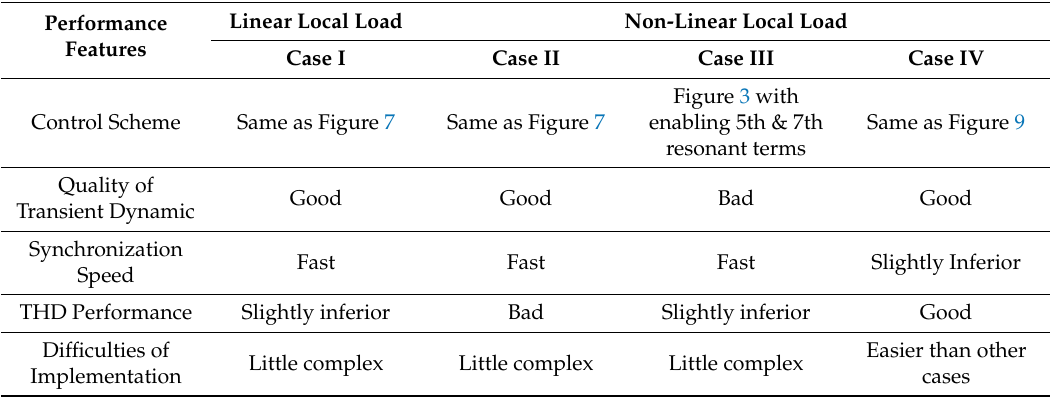
Table 2. Summary of results from the simulation and